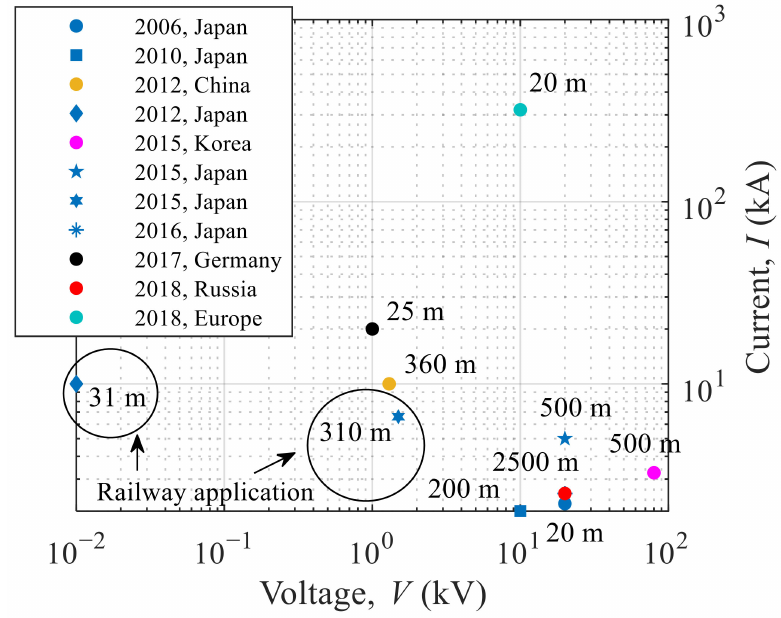
Figure 1. Excerpt of recent projects related to superconducting DC cables in the